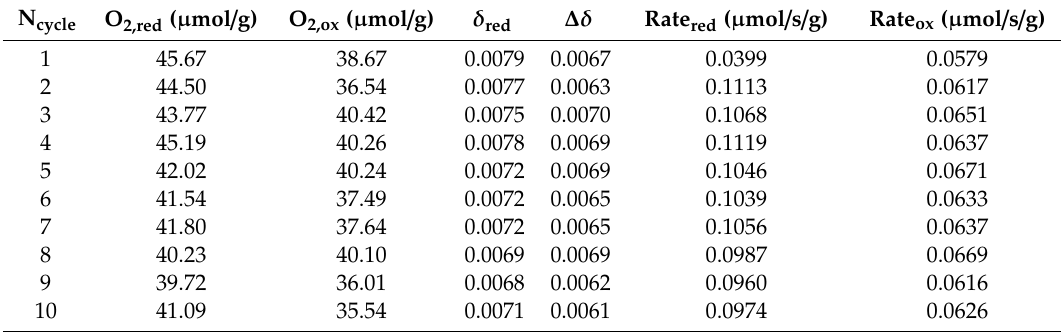
Table 1. O 2 production and consumption during the first cycles and corresponding reduction extents, changes in non-stoichiometry, O 2 rate during reduction and oxidation.